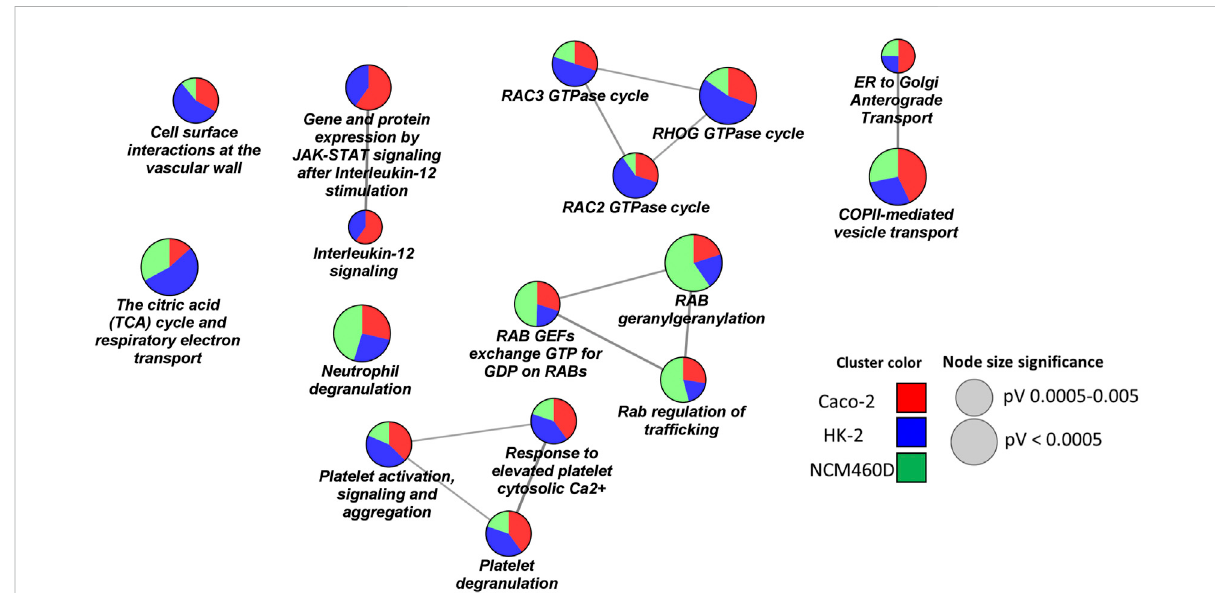
FIGURE 5 Pathways enrichment analysis by ClueGO based on Reactome database. Networks representation of the enriched pathways in each cell line. The terms enriched in HK-2, NCM460D, and Caco-2 are represented as blue, green, and red pie slices, respectively. The slice extent represents the contribution of the speci fi c dataset to the term. The node sizes are proportional to the FDR